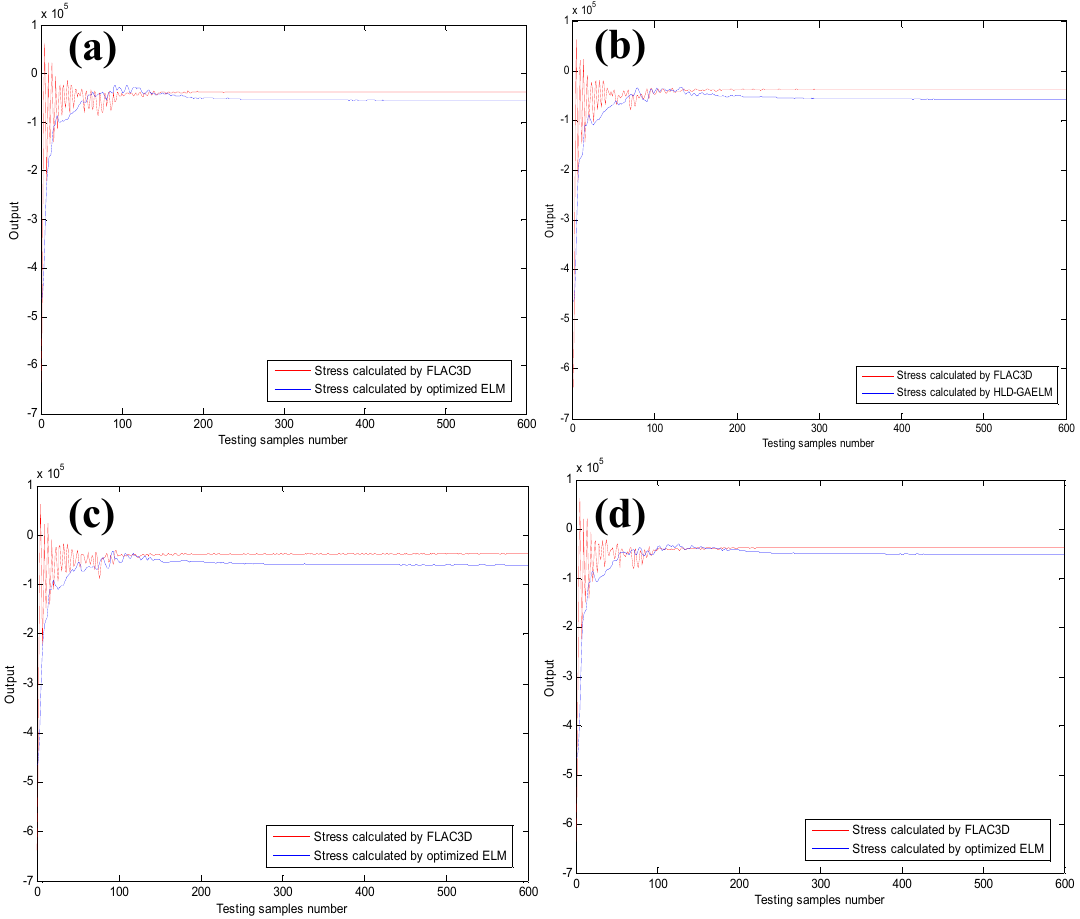
Figure 7. Comparison of Z-direction stress between improved ELM model and FLAC 3D in ( a ) cross-section 5 < y < 6, and ( b ) 10 < y < 11, ( c ) 15 < y < 16 and ( d ) 20 < y < 21.